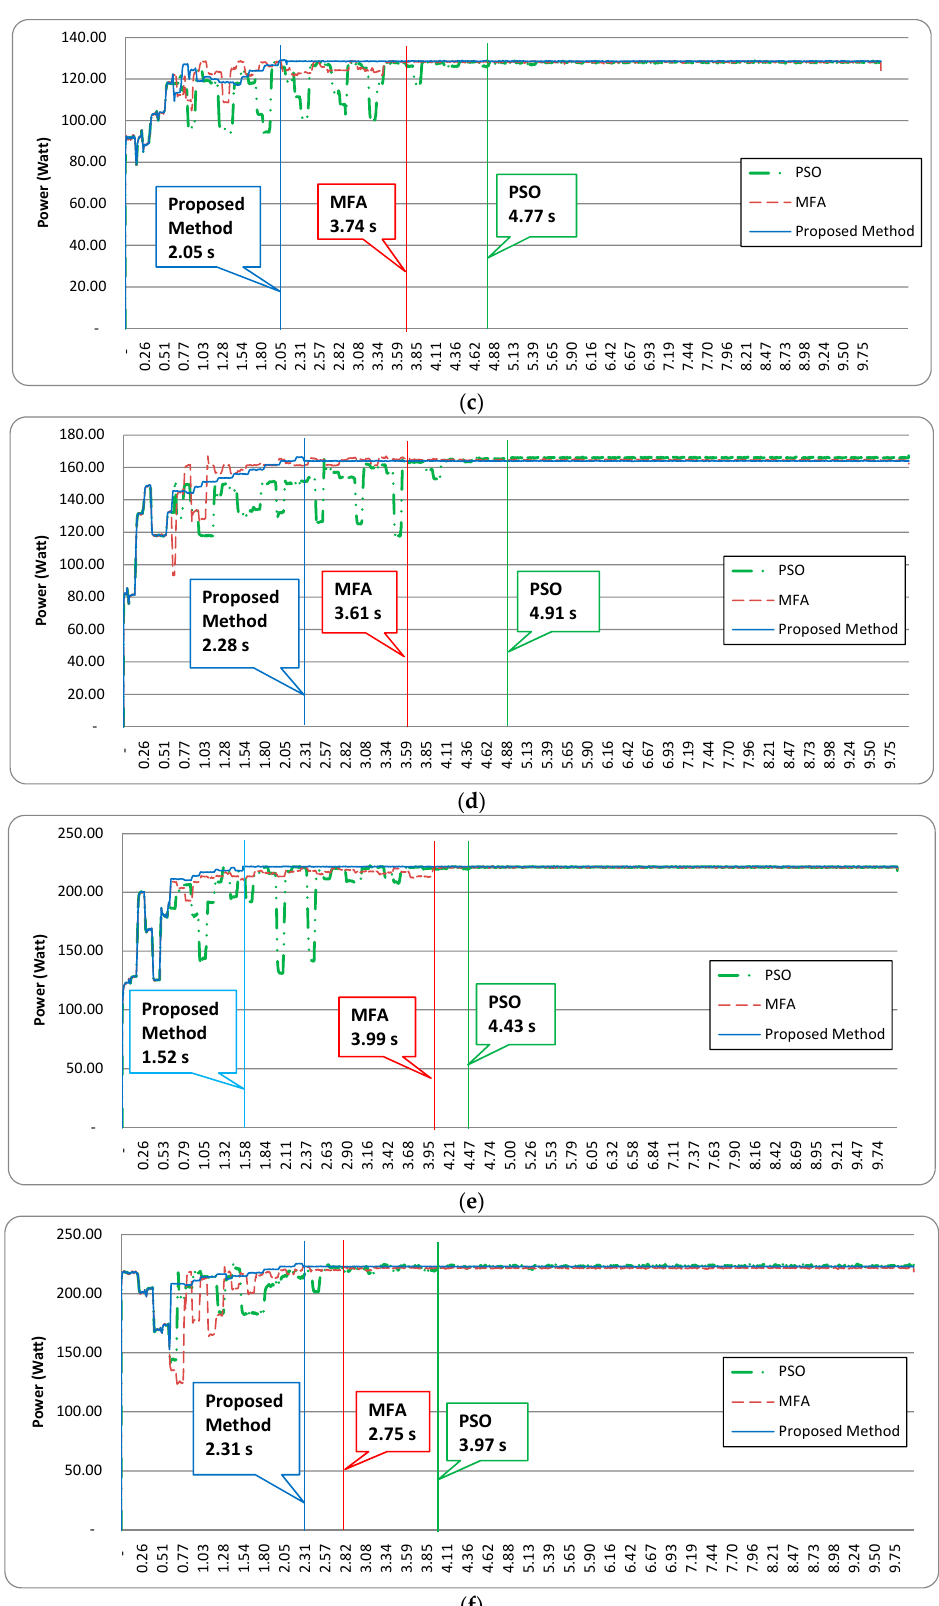
Figure 12. Power tracking evolution of all methods for: ( a ) Curve 1, ( b ) Curve 2, ( c ) Curve 3, ( d ) Curve 4, ( e ) Curve 5, ( f ) Curve 6. Table 4. Tracking efficiencies by experiment.